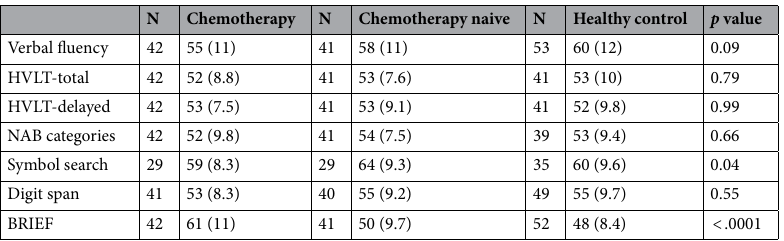
Table 2. Neurocognitive function data shown as mean (standard deviation).